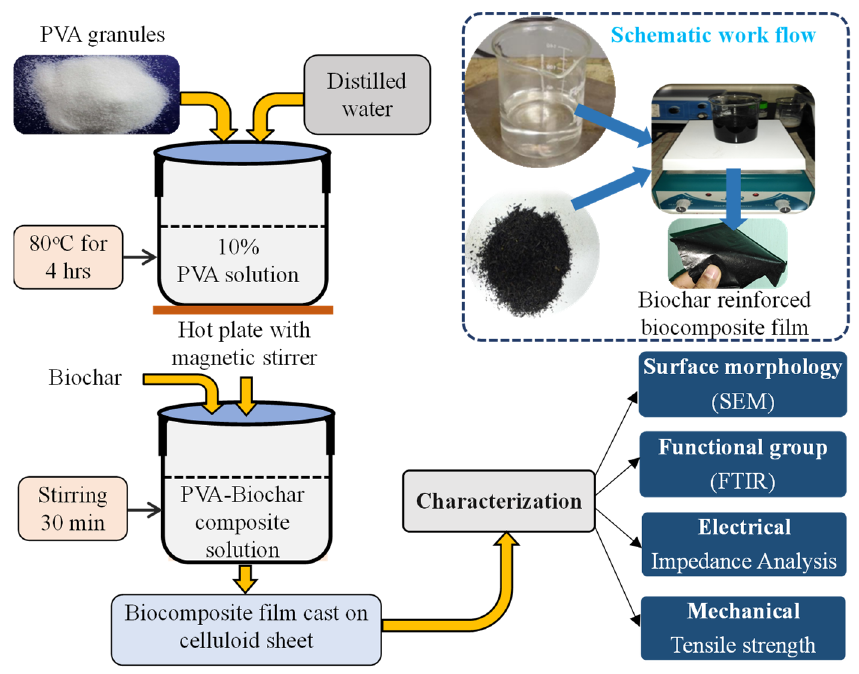
Figure 1. Sugarcane bagasse pyrolyzed biochar preparation.